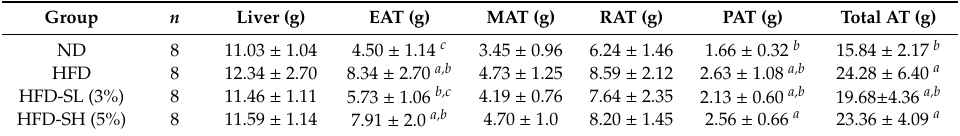
Table 3. E ff ects of the Spergularia marina Griseb powder (SMP) on weights of epididymal, mesenteric, retroperitoneal, perirenal, and total adipose tissues (EAT, MAT, RAT, PAT, Total AT) in HFD-induced obese rats.